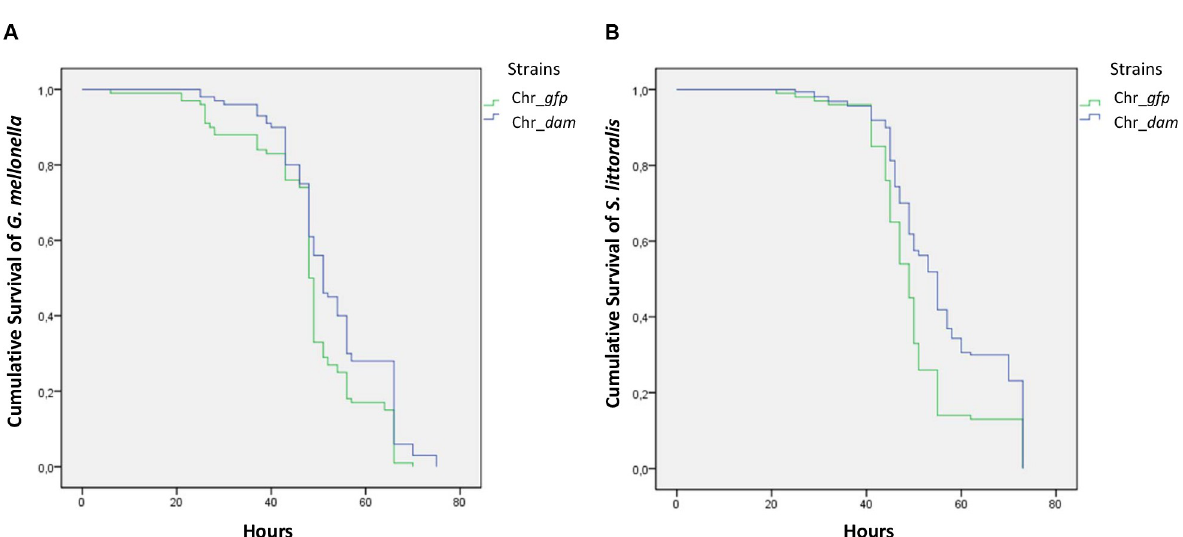
Fig 2. Nemato-bacterial complex pathogenicity by infestation. (A) Survival of G . mellonella larvae after infestation by 10 nematodes associated with Chr_ gfp bacterial strain (green) or Chr_ dam strain (blue). A significant difference of 2 hours was observed for the time needed to kill 50% of the larvae between the two strains (Wilcoxon, p-value < 0.05). (B) Survival of S . littoralis larvae after infestation as described above. A significant difference was observed with an almost 6 hours delay for the Chr_ dam strain (Wilcoxon, p-value < 0.001).